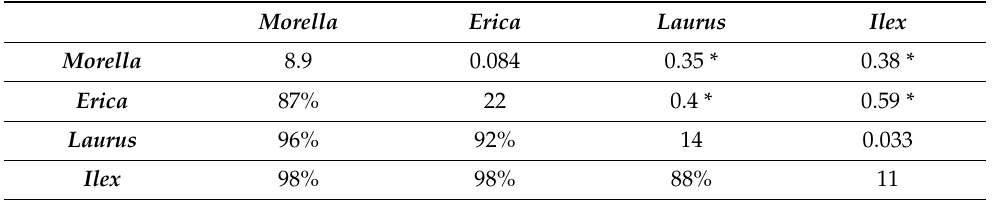
Table 5. SIMPER results. Discriminant species of Ilex canariensis , Laurus novocanariensis , Erica canarien- sis, and Morella faya . We showed species with 75% of total contribution to each group. Percentages of contribution per species are shown in Morella Erica Laurus Ilex Morella 8.9